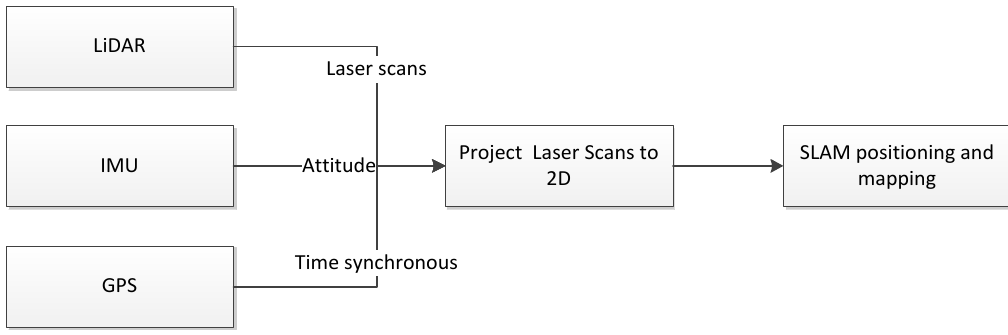
Figure 2. The data process flow of the SLAM-aided stem mapping system.